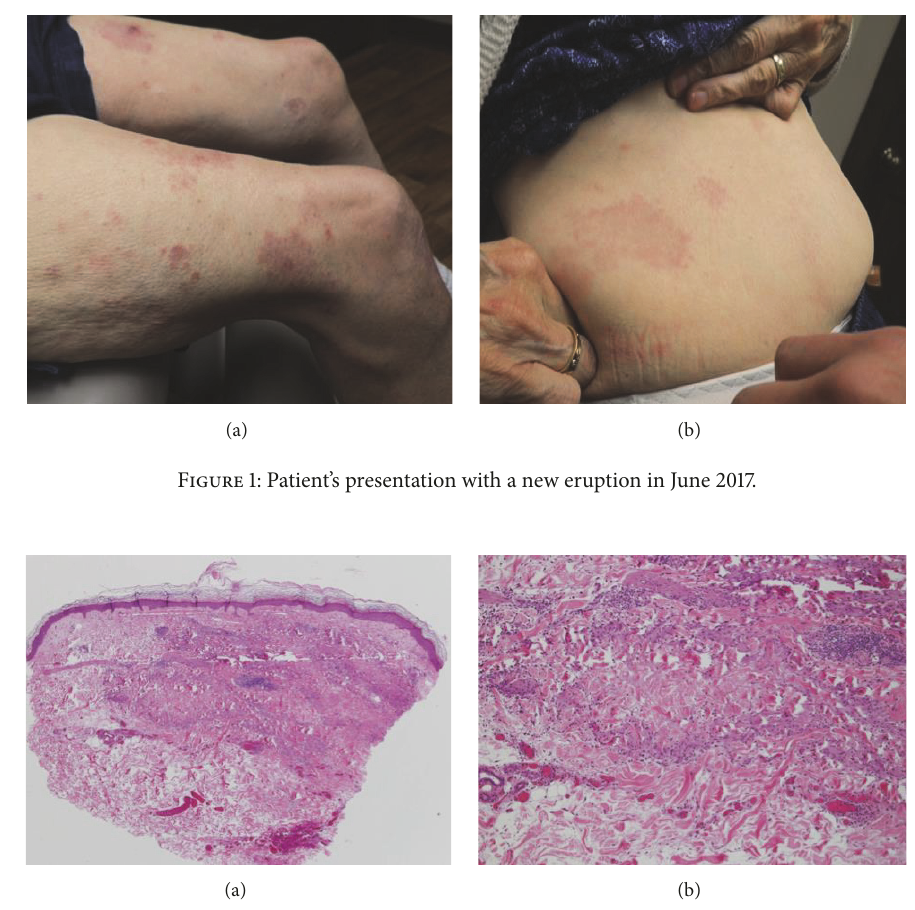
Figure 2: Palisaded histiocytes between focally altered collagen consistent with